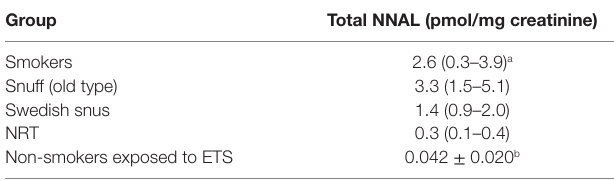
TABLe 1 | Level of NNAL in urine from smokers, users of ‘‘old” snuff in USA (smokeless tobacco), users of ‘‘modern” Swedish snus and of NRT compared to people exposed to eTS (17, 18, 21).